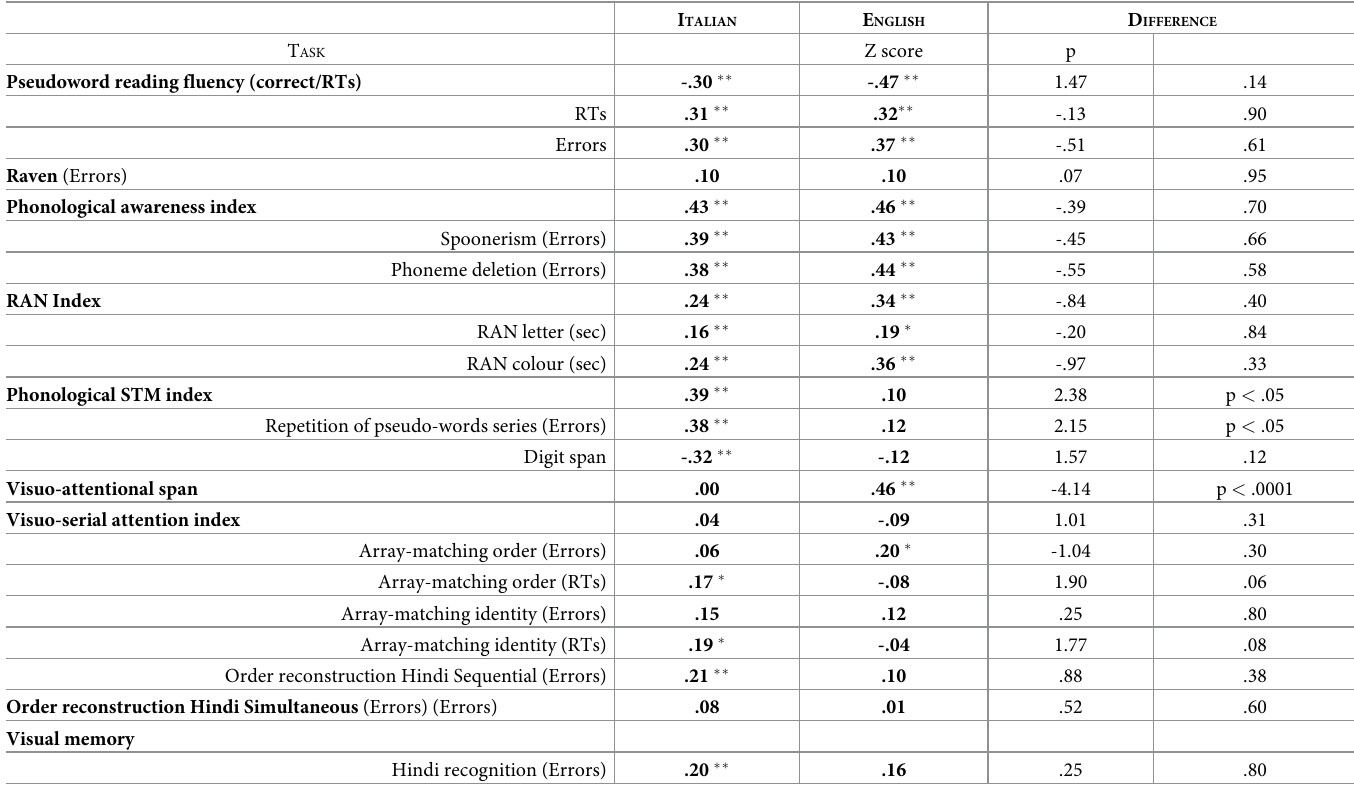
Table 5. Pearson correlations between the Lexical learning task and other cognitive